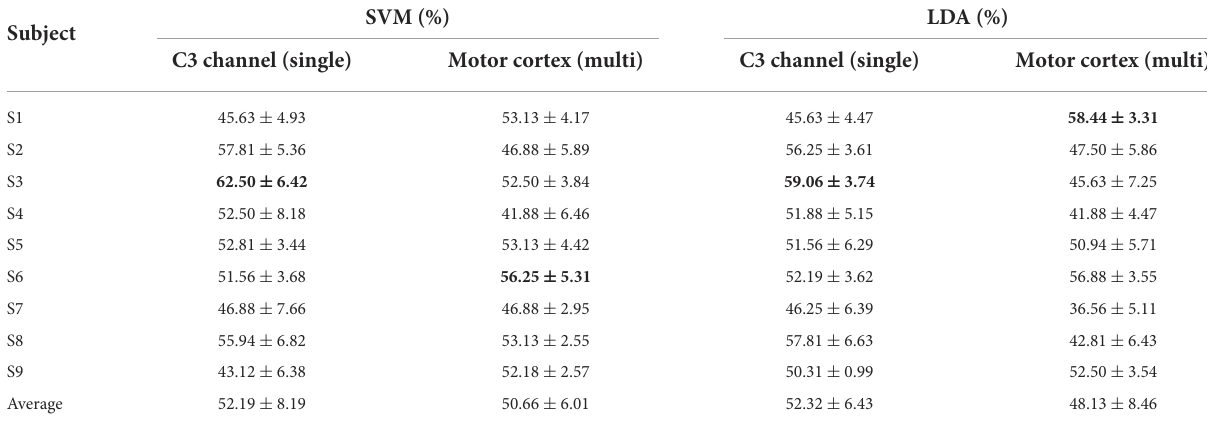
TABLE 2 Pronation vs. supination classification based on ERSP estimation.